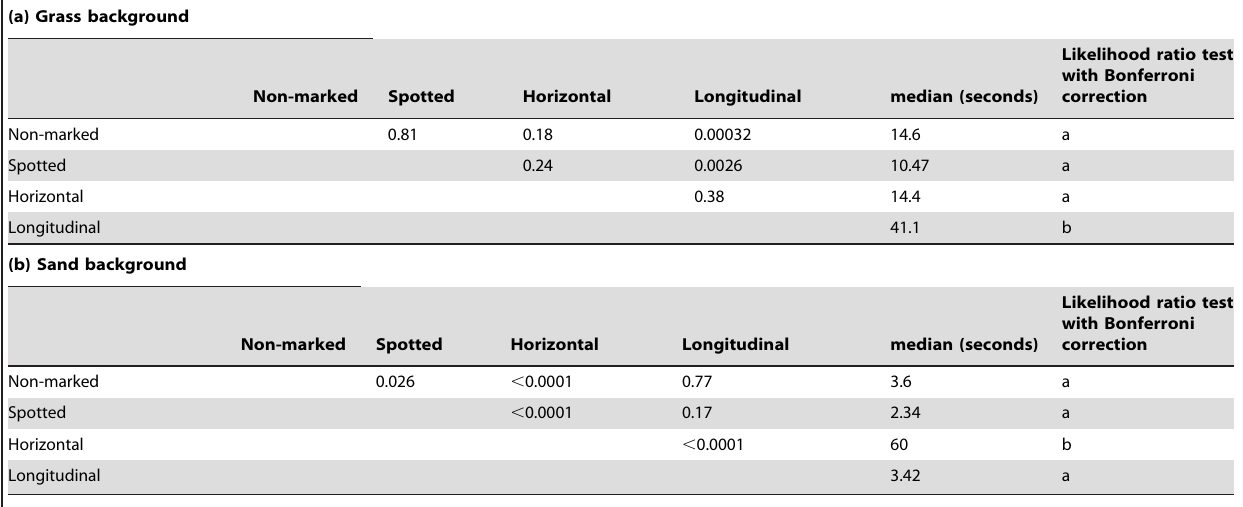
Table 1. Pairwise contrasts among morphs.